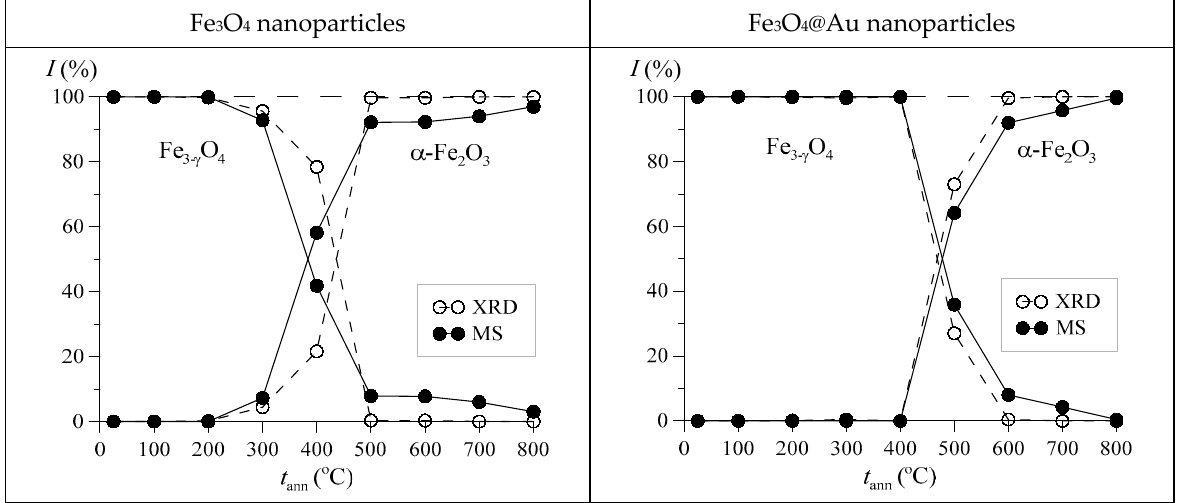
Figure 12. Dependences of the relative contributions to the Mössbauer spectrum (MS) and X-ray diffraction pattern (XRD) of nonstoichiometric magnetite and hematite in Fe 3 O 4 and Fe 3 O 4 @Au nanoparticles on the annealing temperature t ann.